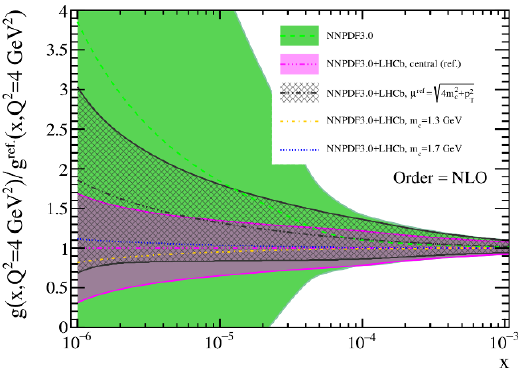
Figure 10 . Same as (cid:12)gure 9 for the NNPDF3.0+LHCb (cid:12)t, comparing the baseline results with those obtained varying the scale (cid:22) (ref) and the value of the charm mass m c